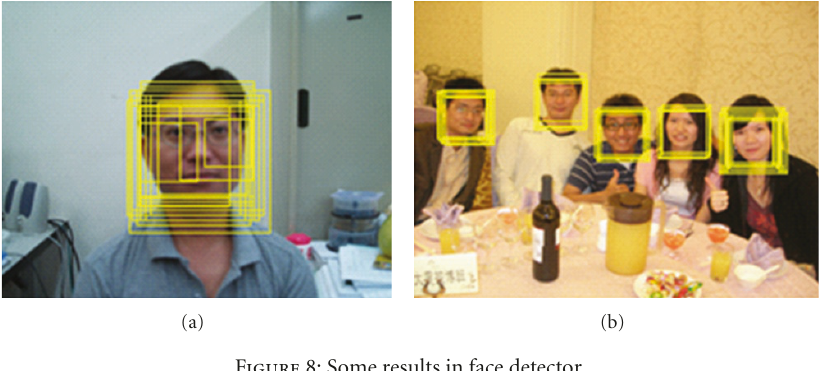
Figure 8: Some results in face detector.